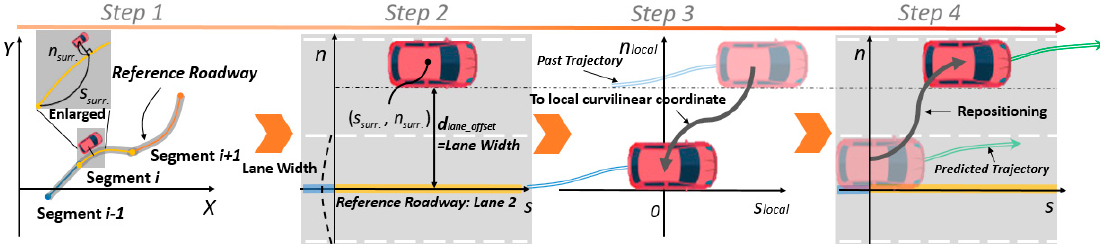
Figure 5. Description of the data processing steps. Step 1: Global Cartesian coordinates; Step 2: Transformation to the curvilinear coordinates; Step 3: Translation to the local curvilinear coordinates; Step 4: Repositioning to the curvilinear coordinates.